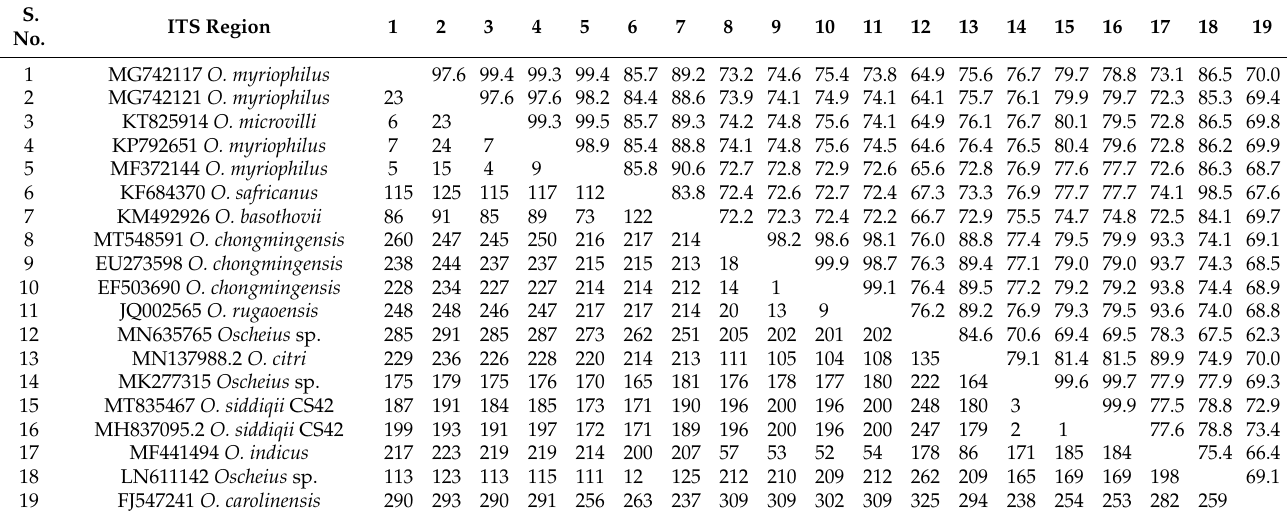
Table 5. Pairwise distances of the ITS region of the rDNA among species of the “ insectivorus ” group of the genus Oscheius . Values above the diagonal represent percent similarities, and values below the diagonal present numbers of character